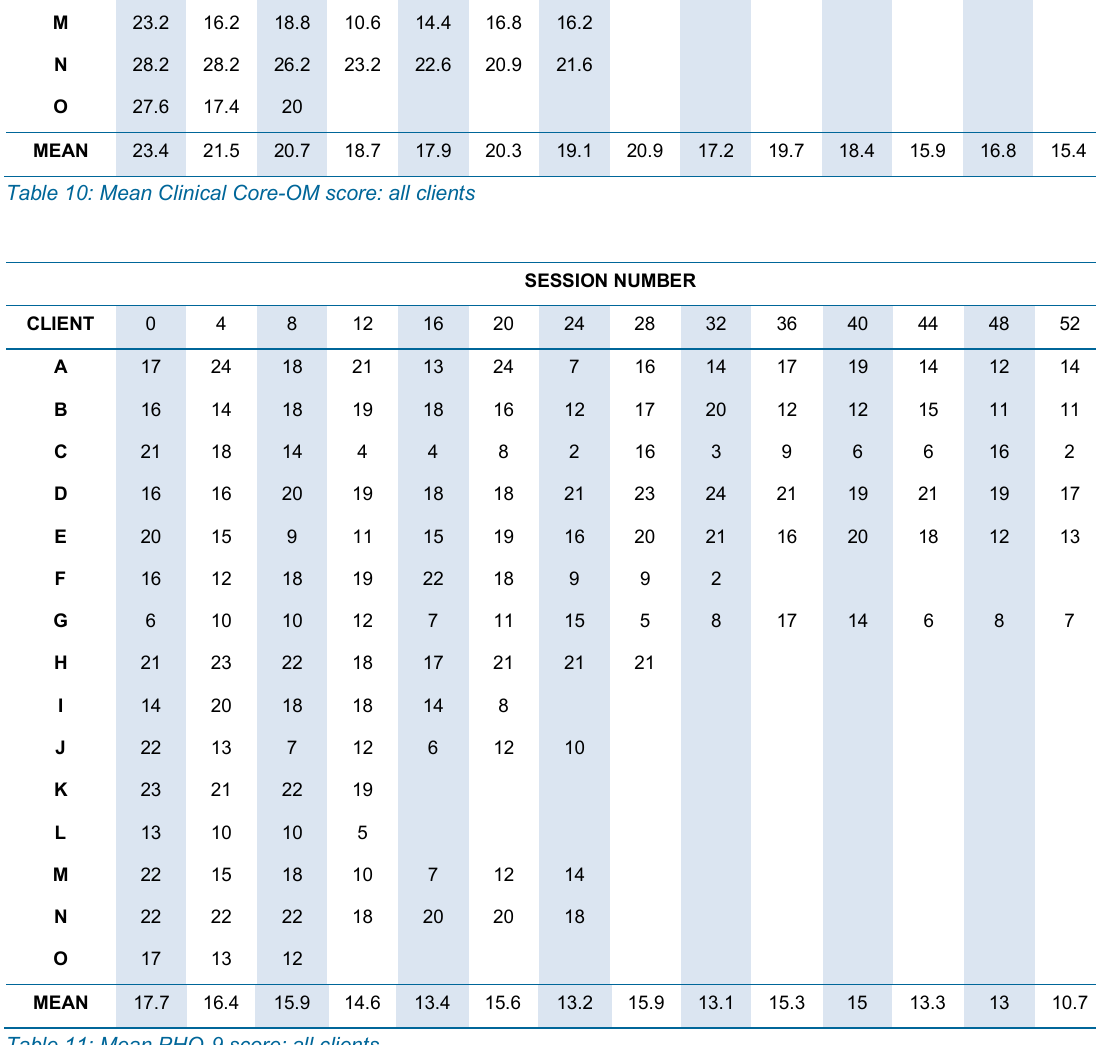
Table 11: Mean PHQ-9 score: all